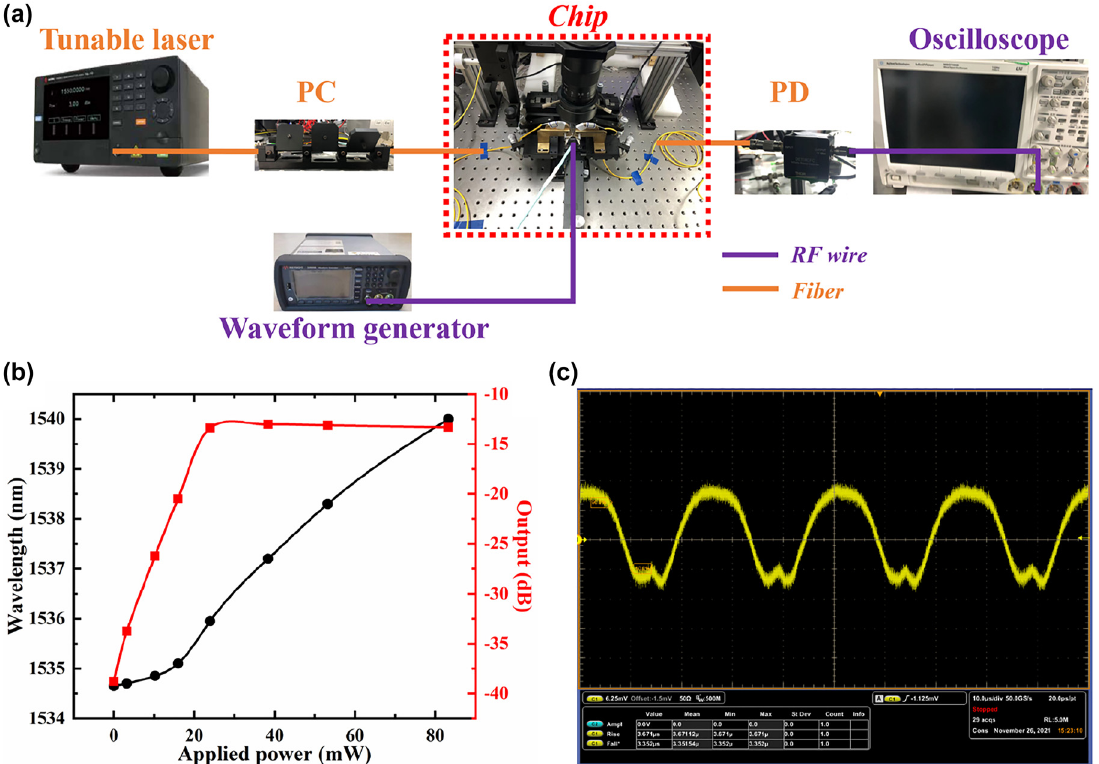
Figure 8: Temporal response of the topological MRM. (a) Experimental setup for the to modulation of the VPC-based topological MRM. (b) The resonant wavelength shift of such MRM and the measured output as a function of the applied electrical power. (c) Dynamic characteristics of the topological MRM on the oscilloscope at a modulation frequency of 40